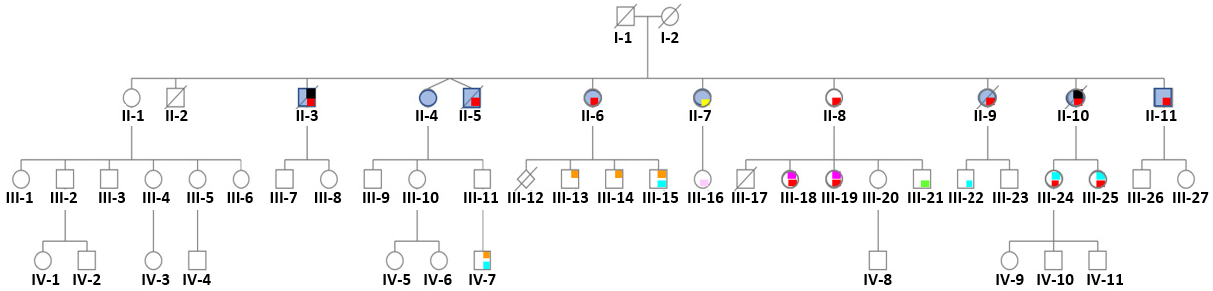
Figure 1. Pedigree of the informative family whose mother (I-2) was treated with DES (30 mg/day) for 3 months after each delivery to inhibit lactation. Only the first child (II-1) was not exposed to DES in utero. Daughter II-1 and her descendants do not have any psychiatric disorders. No history of psychiatric disorders was reported for the maternal and paternal sides. Legend: red = bipolar disorder, yellow = psychosis borderline, blue = attempted suicide(s), black = suicide, orange = autism spectrum disorder, light blue = dyspraxia and learning disabilities, light pink = mood and sleep disorders, green = behavioral disorders, fuchsia = eating disorders.